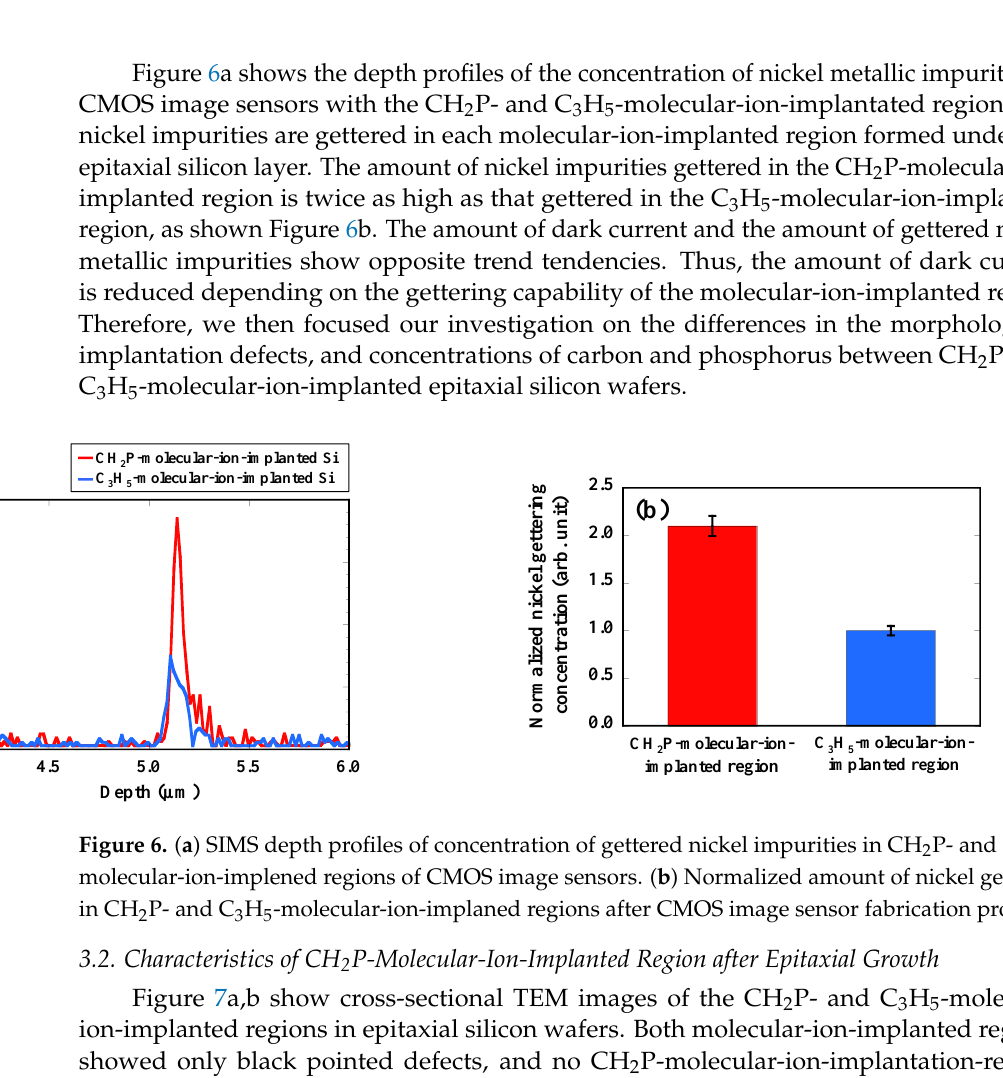
Figure 5. Cross-sectional BMD density and size determined by optical microscopy observant ion of CMOS images sensor fabricated with CH 2 P- and C 3 H 5 -molecular-ion-implanted epitaxial silicon wafers.